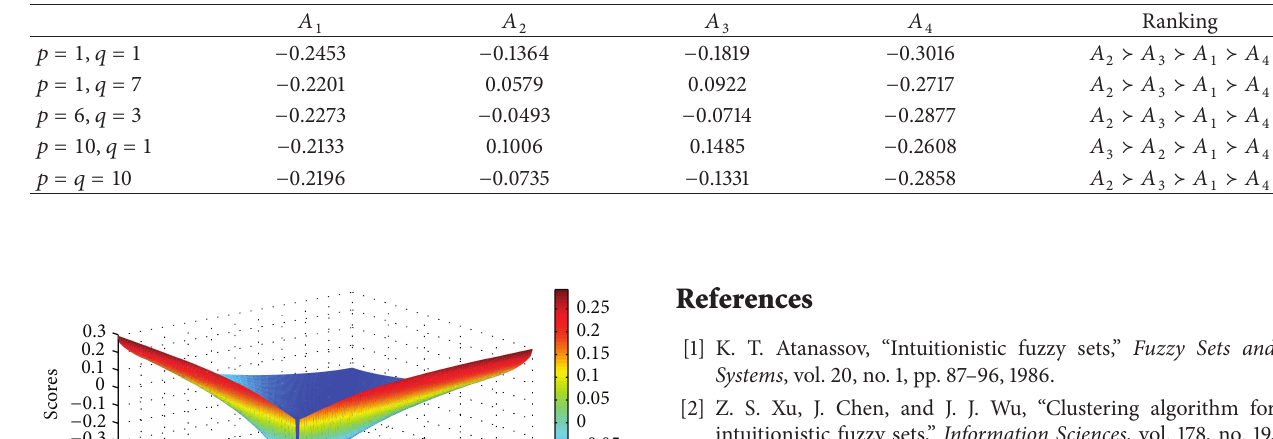
Table 6: Score values obtained by the IIFWBM operator and the rankings of Districts.